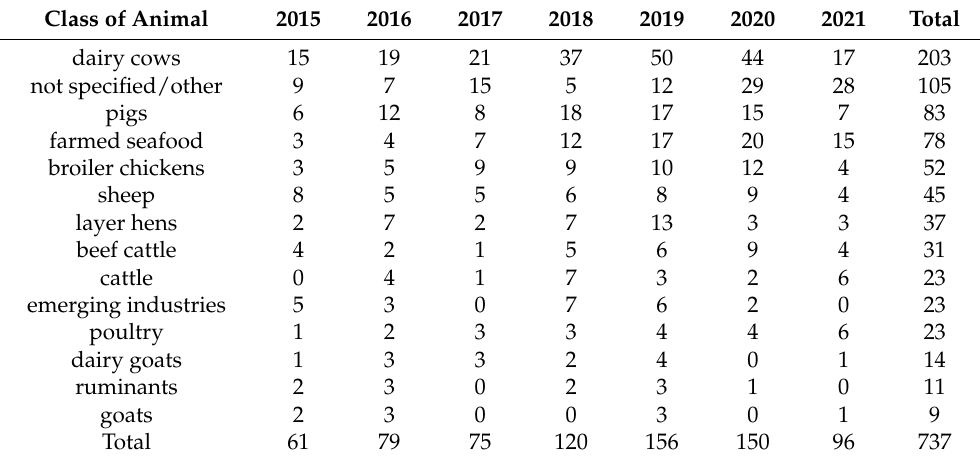
Table 2. Number of articles per class of animals and year. Goats included articles investigating goats in general with no focus on dairy, meat or fibre production. Ruminants included articles investigating ruminant production in general with no focus on any particular species or animal